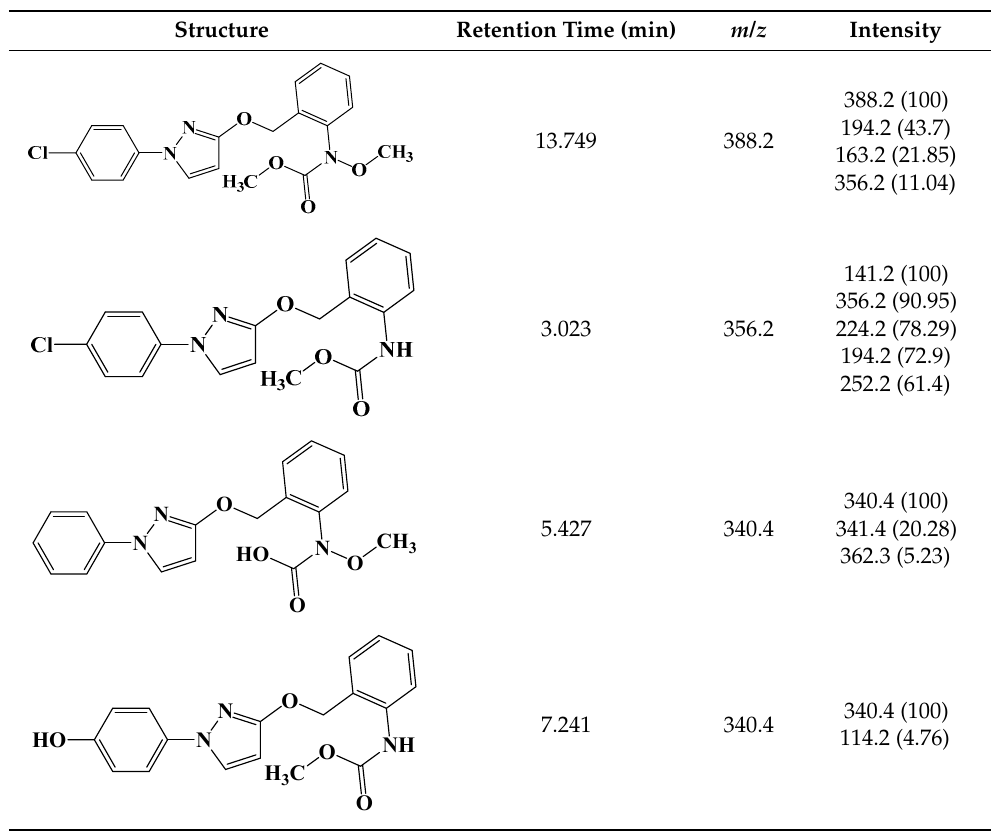
Figure 7. The chromatogram before and after plasma treatment was obtained by HPLC-MS/MS. Table 3. Mass spectra data and structures of identified intermediates by HPLC-MS/MS for